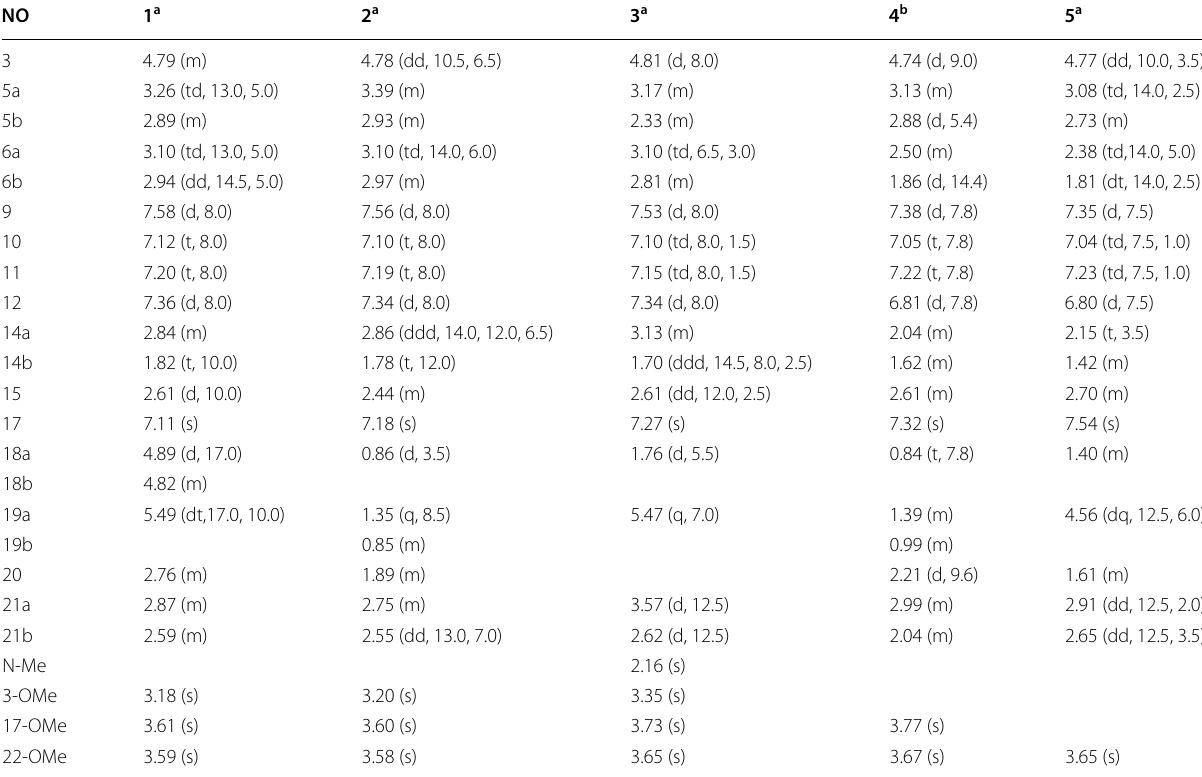
Table 1 1 H NMR spectroscopic data for compounds 1–5 ( δ in ppm, J in